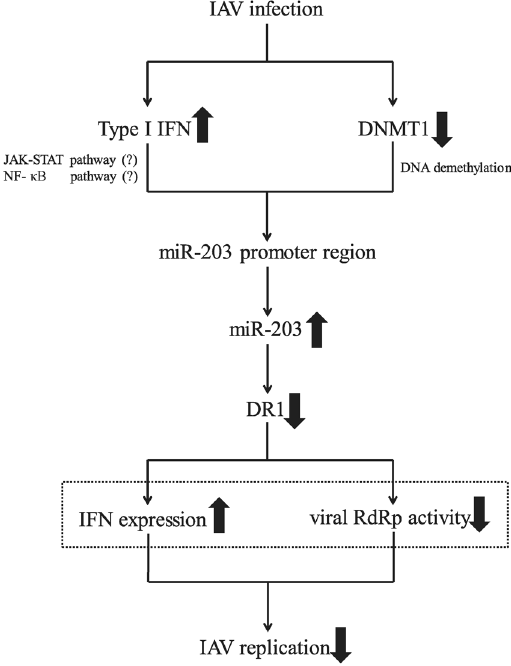
Figure 8. A putative model of the relationship between influenza A virus (IAV) infection and miR-203 expression. IAV infection induces up-regulation of miR-203 via two signaling pathways. Type I interferon (IFN) stimulates the promoter region of miR-203 directly, whereas down-regulation of DNA methyltransferases 1 (DNMT1) leads to DNA demethylation of CpG islands in the miR-203 promoter region. Both of the two processes promote transcription and increase expression of miR-203. MiR-203 suppresses expression of its target gene, down-regulator of transcription 1 (DR1). Suppression of DR1 increases expression of IFN and promotes IAV RNA-dependent RNA polymerase (RdRp) activity, thereby inhibiting IAV replication. The phenomena depicted in the dashed box have been shown by previous studies. The thick arrows indicate up- or down-regulation of gene